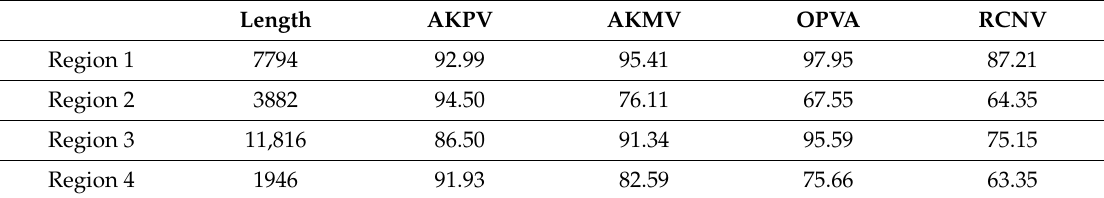
and 3 are neighboring genomic regions, as shown in Figure 4. Gaps were not removed for this